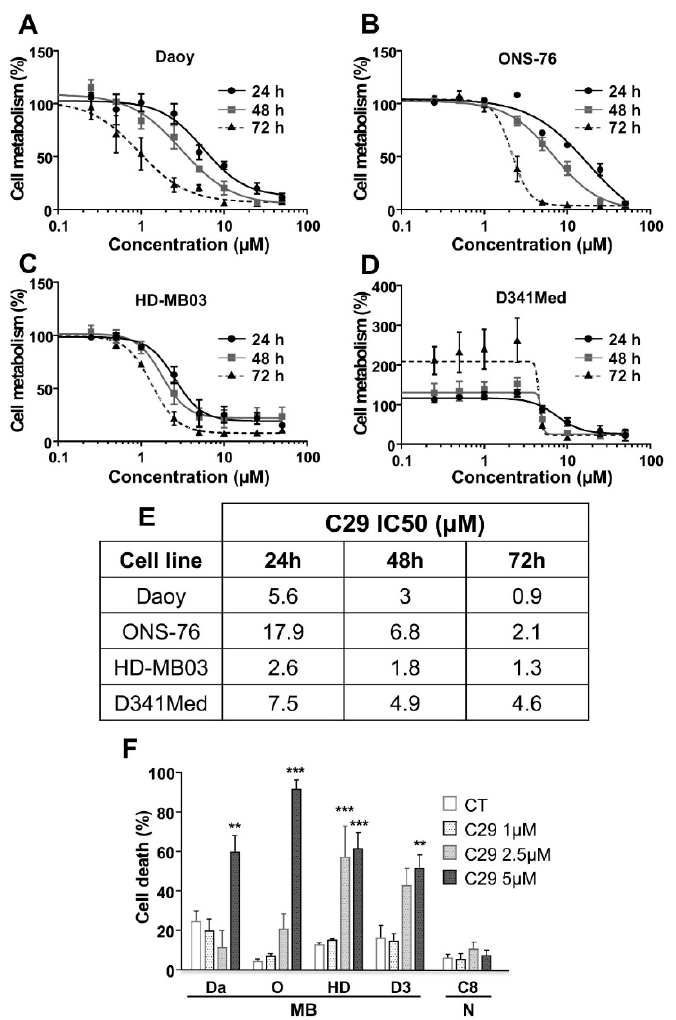
Figure 3. A new pharmacological inhibitor of CXCR1/2, C29, inhibits the metabolism of MB cells. ( A – D ). Cytotoxic effect induced by C29 on Daoy ( A ), ONS-76 ( B ), HD-MB03 ( C ), and D341Med ( D ) cells. Cells were treated with increasing doses of the inhibitor for 24, 48, and 72 h. Cytotoxicity was measured using the XTT assay. Absorbance measurements were performed at 450 nm, n = 3. ( E ) Table with the different IC50 values for all conditions. ( F ) Cell death after 48 h of treatment with control (DMSO, CT) or C29 1, 2.5 or 5 µM treatment, on MB cells, and normal cells (N), n = 3. Statistics were performed using the one-way method ANOVA. ** p < 0.01, *** p < 0.001. For this figure, Daoy = Da, ONS-76 = O, HD-MB03 = HD, D341 = D3, C8D1A = C8.